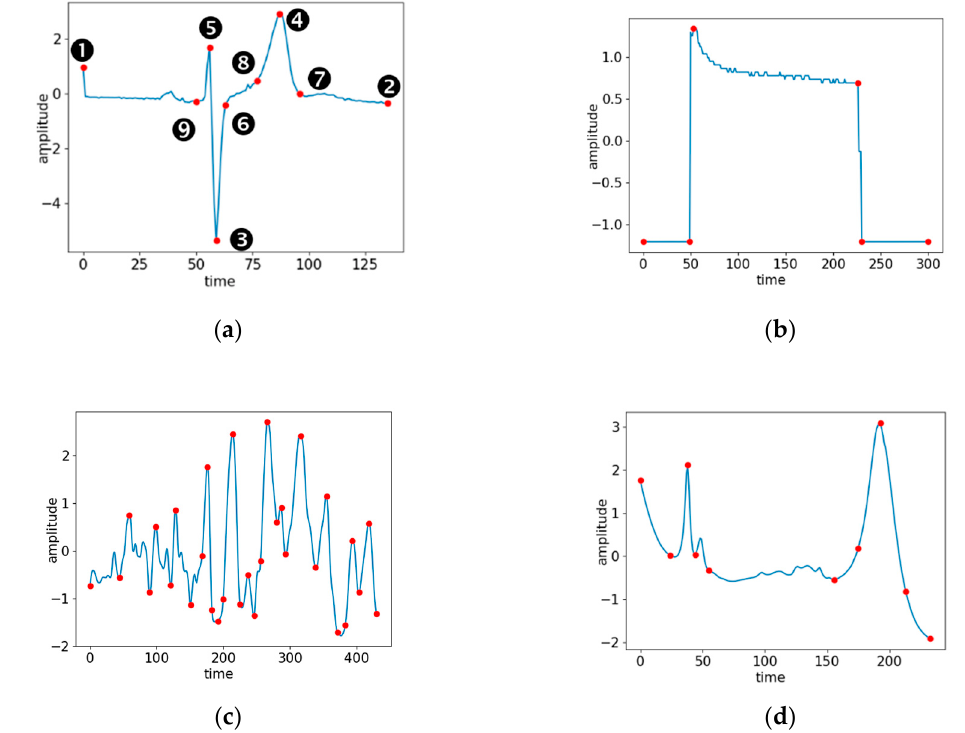
Figure 1. Examples of time series segments for four data sets, which are ECGFiveDays (ECG = electrocardiogram) ( a ), FreezerSmallTrain ( b ), Ham ( c ) and Wine ( d ), respectively.